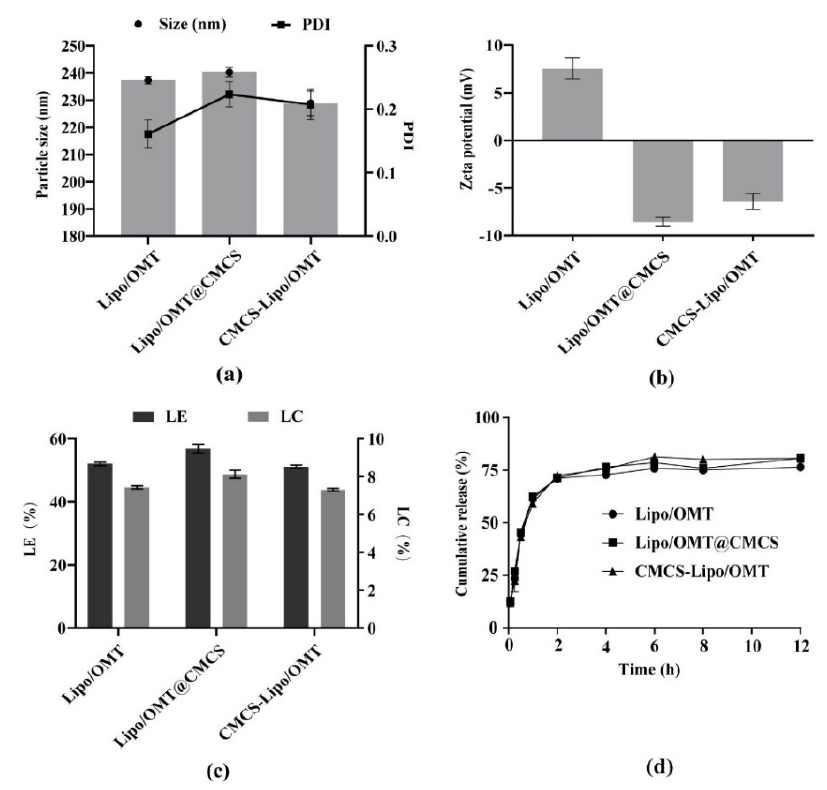
Figure 1. Characterization of OMT liposomal preparations. ( a ) Evolution of particle size, PDI and ( b ) zeta potential of OMT liposomal preparations. ( c ) Drug loading efficiency and loading capacity of OMT in different liposomal preparations. ( d ) In vitro release behavior of OMT from different liposomal preparations in pH 7.4 PBS. All data are expressed as mean ± SD ( n = 3).